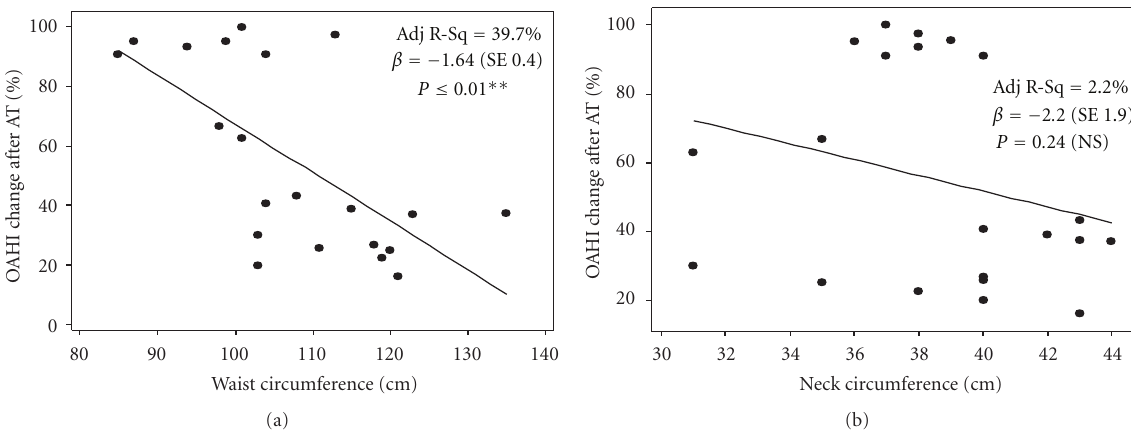
Figure 1: Univariate linear regression model (Fat distribution). Graphs demonstrate the correlation between either waist circumference (a) or neck circumference (b) and the percentage of apnea-hypopnea index (OAHI) change after adenotonsillectomy (AT) in obese adolescents.